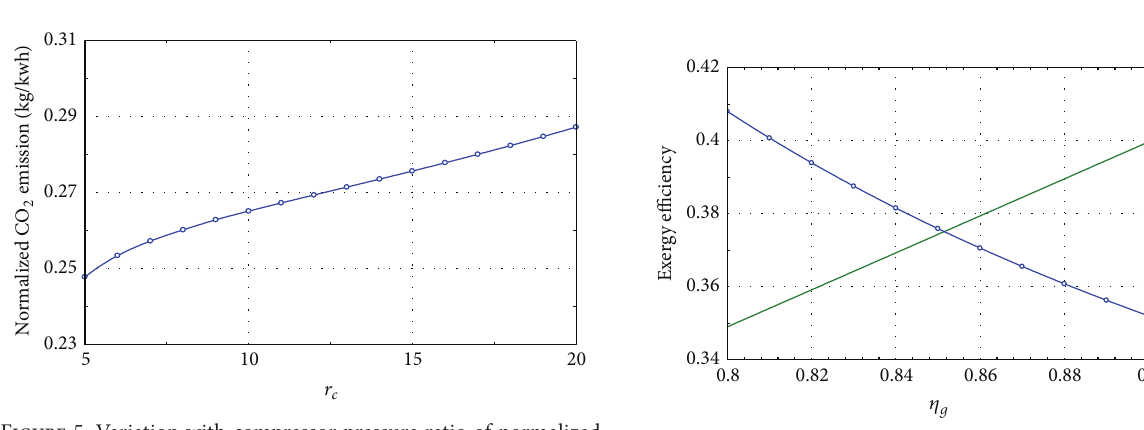
Figure 5: Variation with compressor pressure ratio of normalized CO 2 emission.